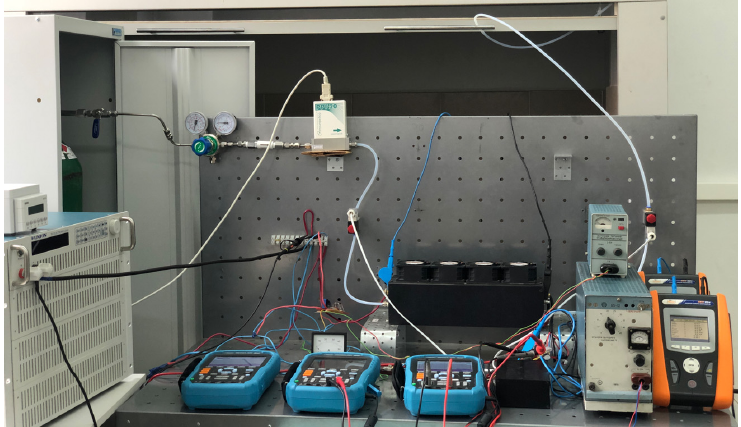
Figure 5. Appearance of the fuel cell test bench.